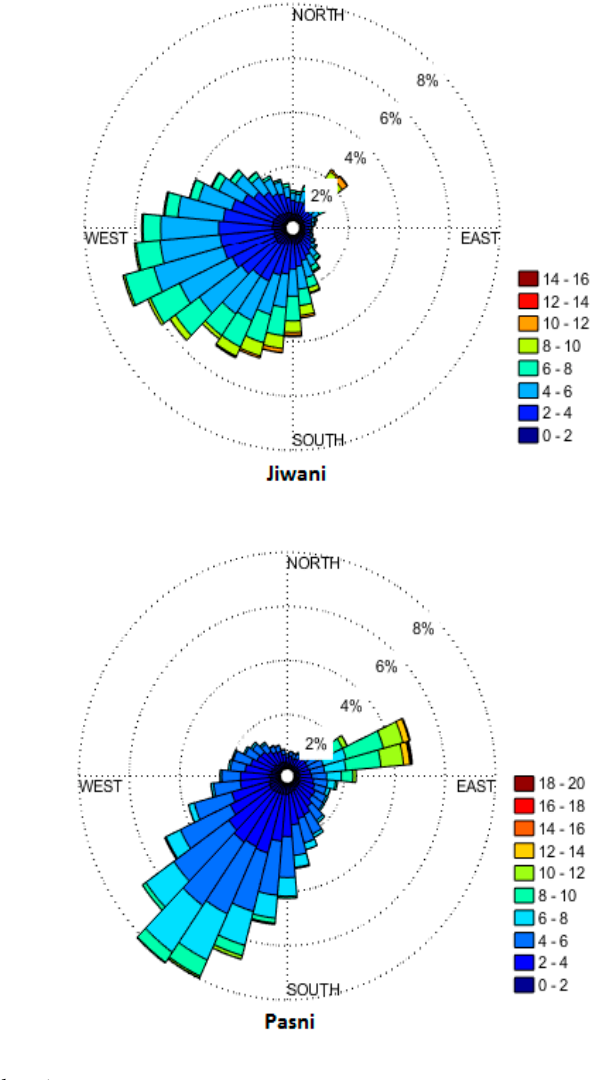
Figure 2. Wind rose plots for all regions.